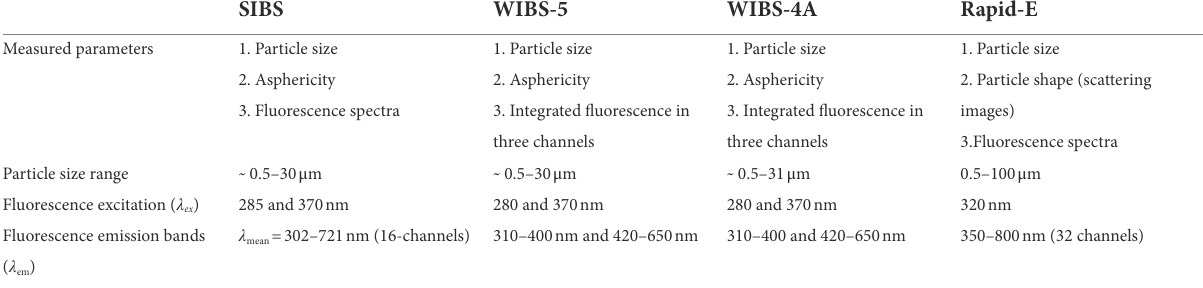
TABLE 2 Comparison of parameters for different LIF based bioaerosol detection